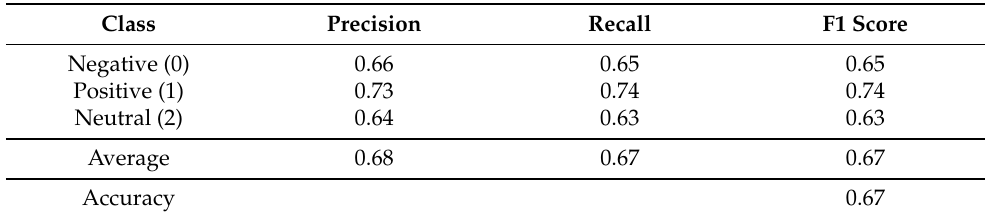
Figure 8. Loss comparison of the binary and ternary classifications. Table 5. Class-wise precision and recall chart for the RUECD